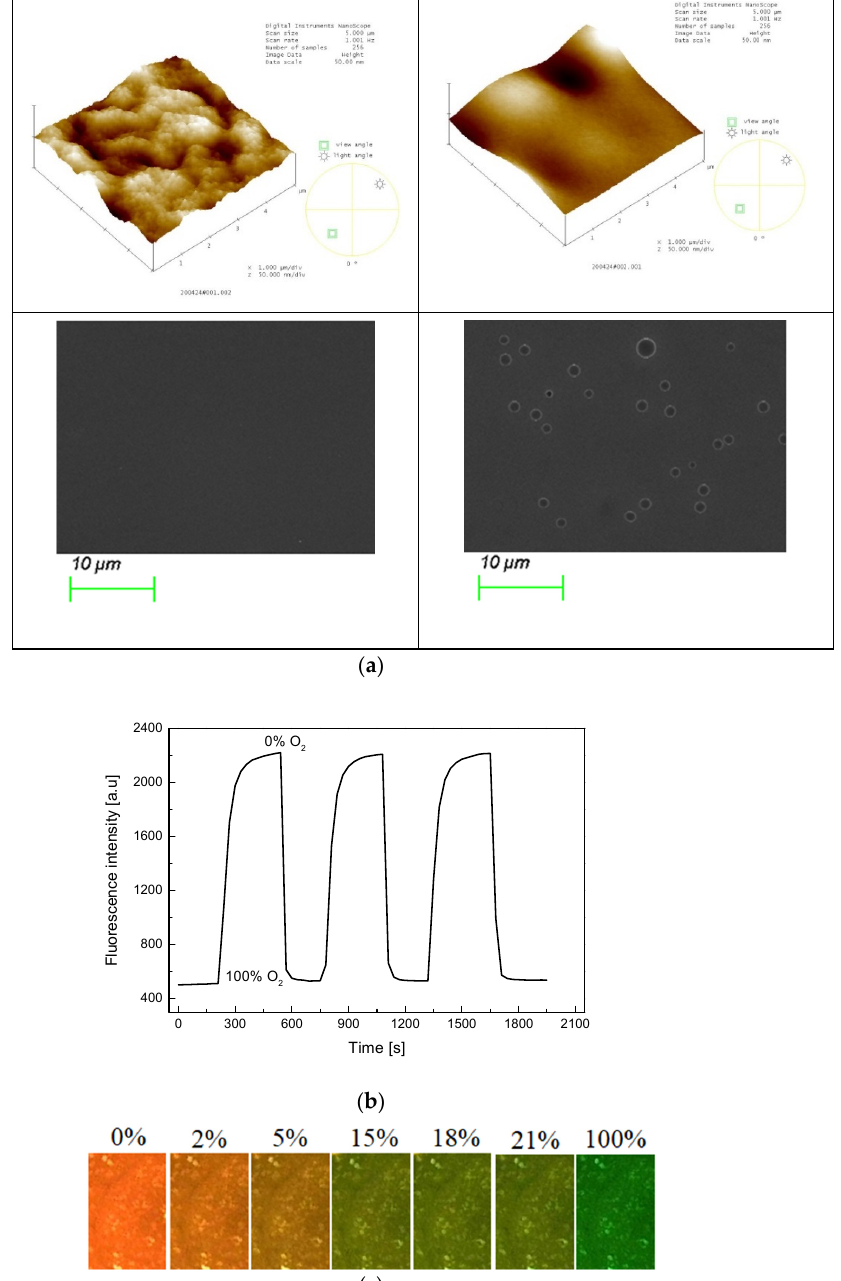
Figure 2. ( a ) AFM and SEM images of sol–gel GA (left photos) and PS@C6^PtP membrane (right photos); ( b ) repeatability of PS@C6^PtP membrane when exposed to a consequence of 100% or 0% oxygen gas; ( c ) photo images of PS@C6^PtP membrane under exposure to different concentrations of oxygen gas.